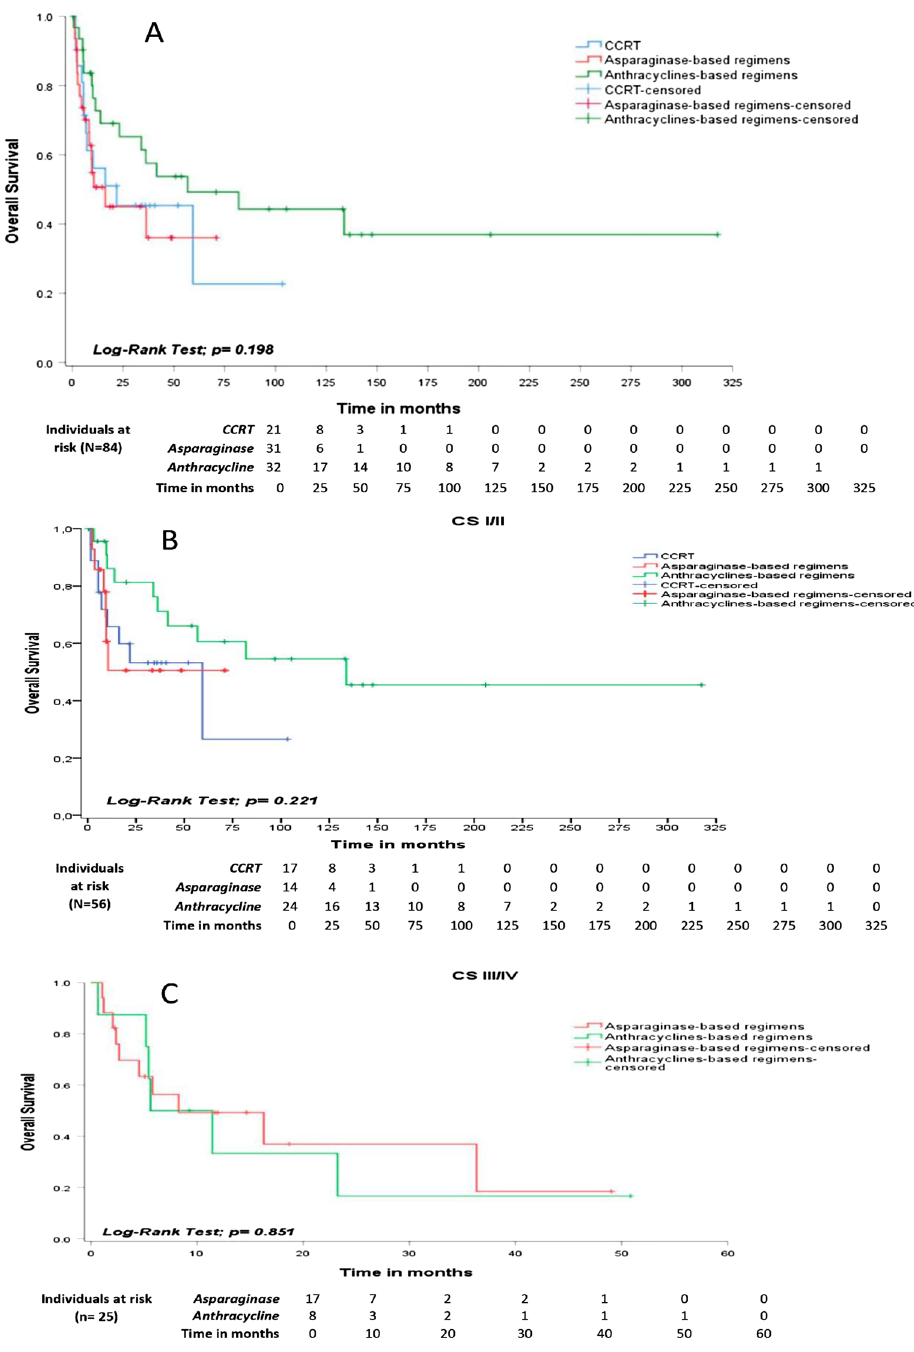
Figure 2. ( A ) OS according to groups of treatment: blue-line [CCRT-VIPD], green-line [SCRT based on athracyclines] and red-line [asparaginase-based regimens], p = 0.198. ( B ) Localized-disease (CS IE and IIE) – OS comparing CCRT/VIPD (blue-line), SCRT followed by anthracycline-based regimens (green-line) and SCRT followed by asparaginase-based chemotherapy, p = 0.221. ( C ) Advanced-stagedisease (CS III and IV) – OS comparing anthracycline-based regimens (green-line) and asparaginase-based regimens (red-lne), p =